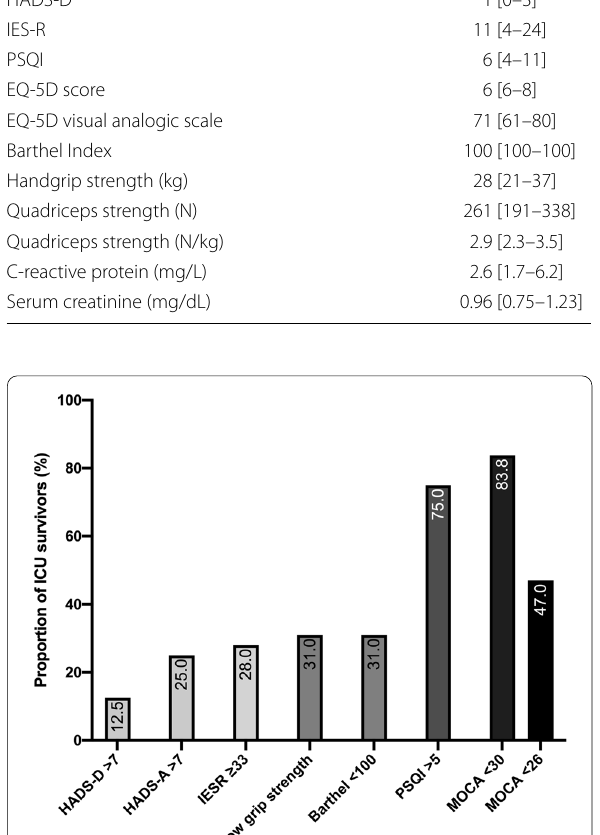
Fig. 2 Proportion of survivors with abnormal results to the